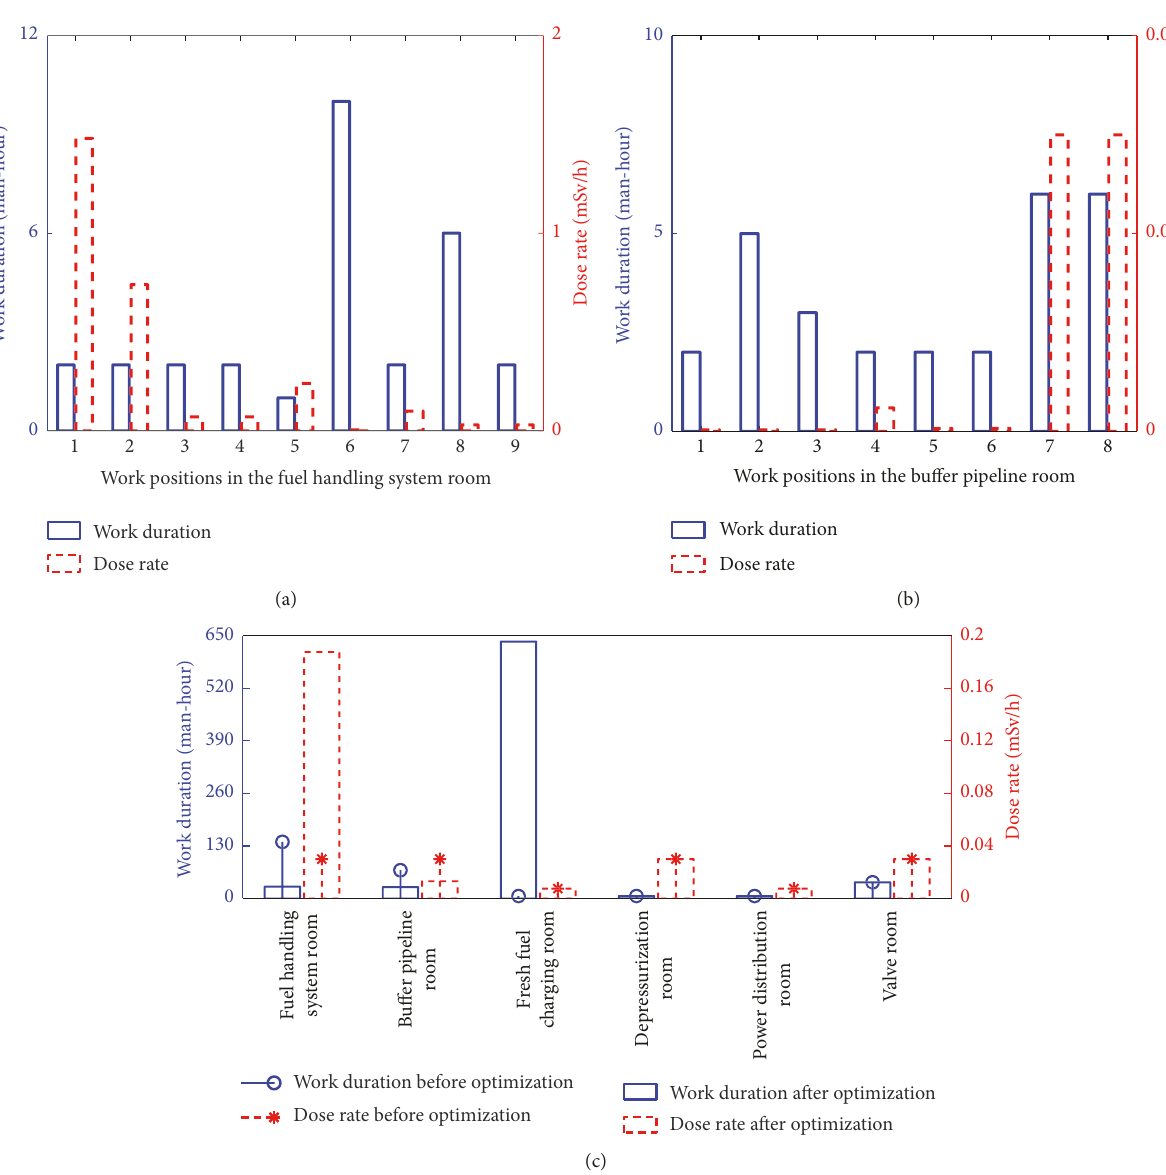
Figure 8: Dose rates and work durations in (a) the fuel handling system room; (b) the buffer pipeline room; and (c) different rooms of the fuel handling